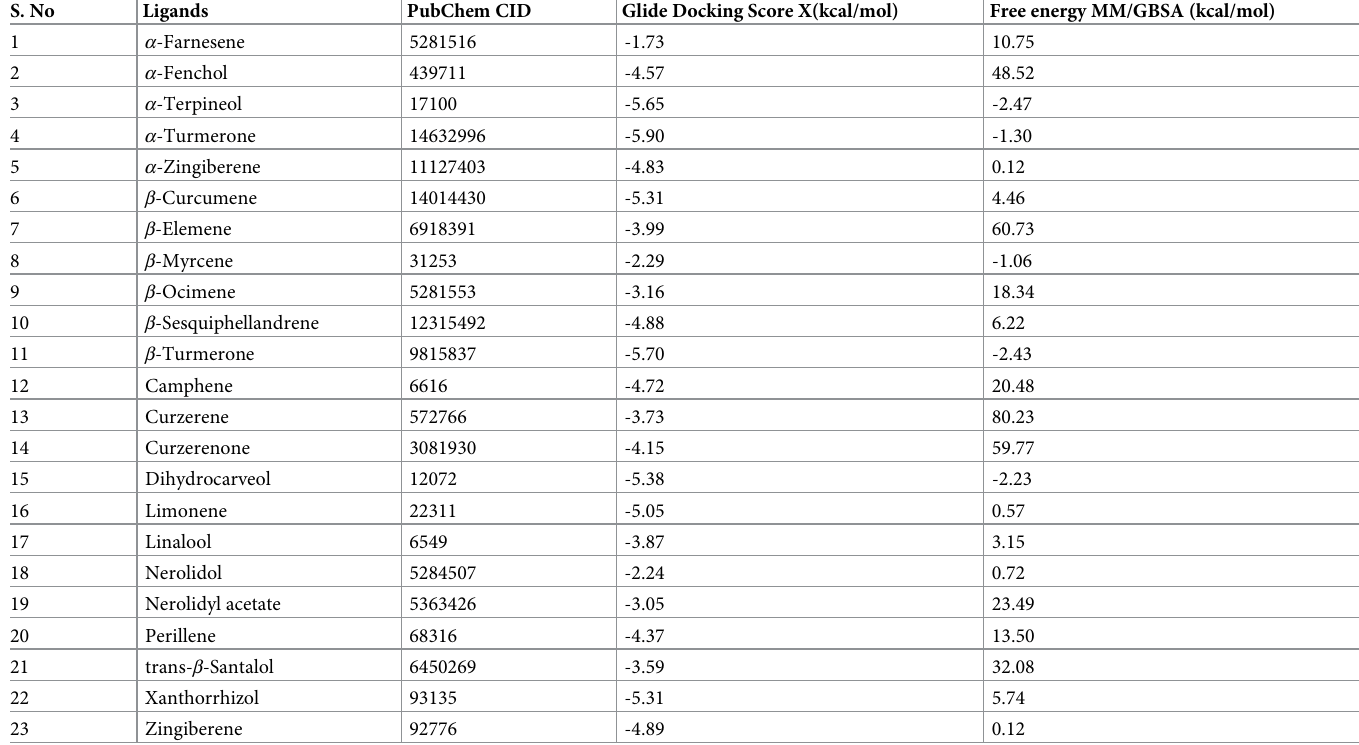
Table 1. The Glide XP docking scores and MM-GBSA estimations (kcal/mol) of the compounds derived from essential oils of Curcuma species with 5-LOX protein (NC: Not